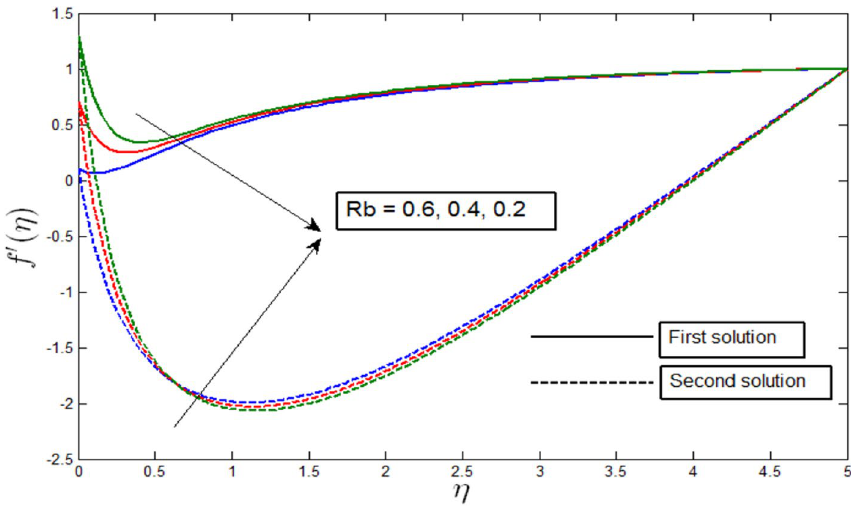
′ (η) Figure 4. Velocity profile f for various Rb when (cid:31) = − 3, γ = 5, Lb = 0.5, Le = 0.5, Pb = 0.5, Nr = 0.5, A = 0.2.